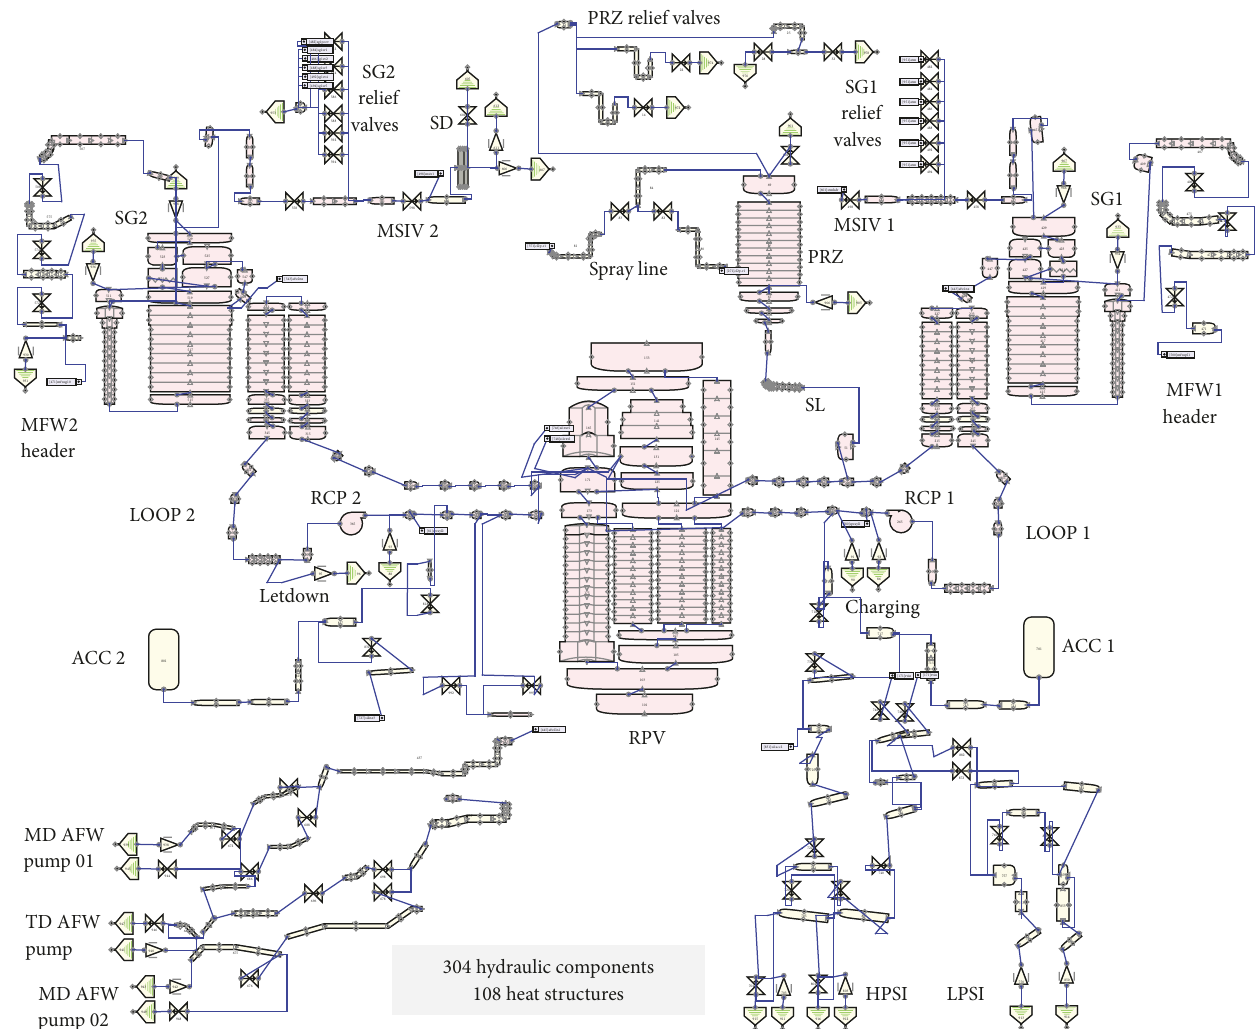
Figure 1: Krˇsko NPP nodalization scheme: SNAP hydraulics component